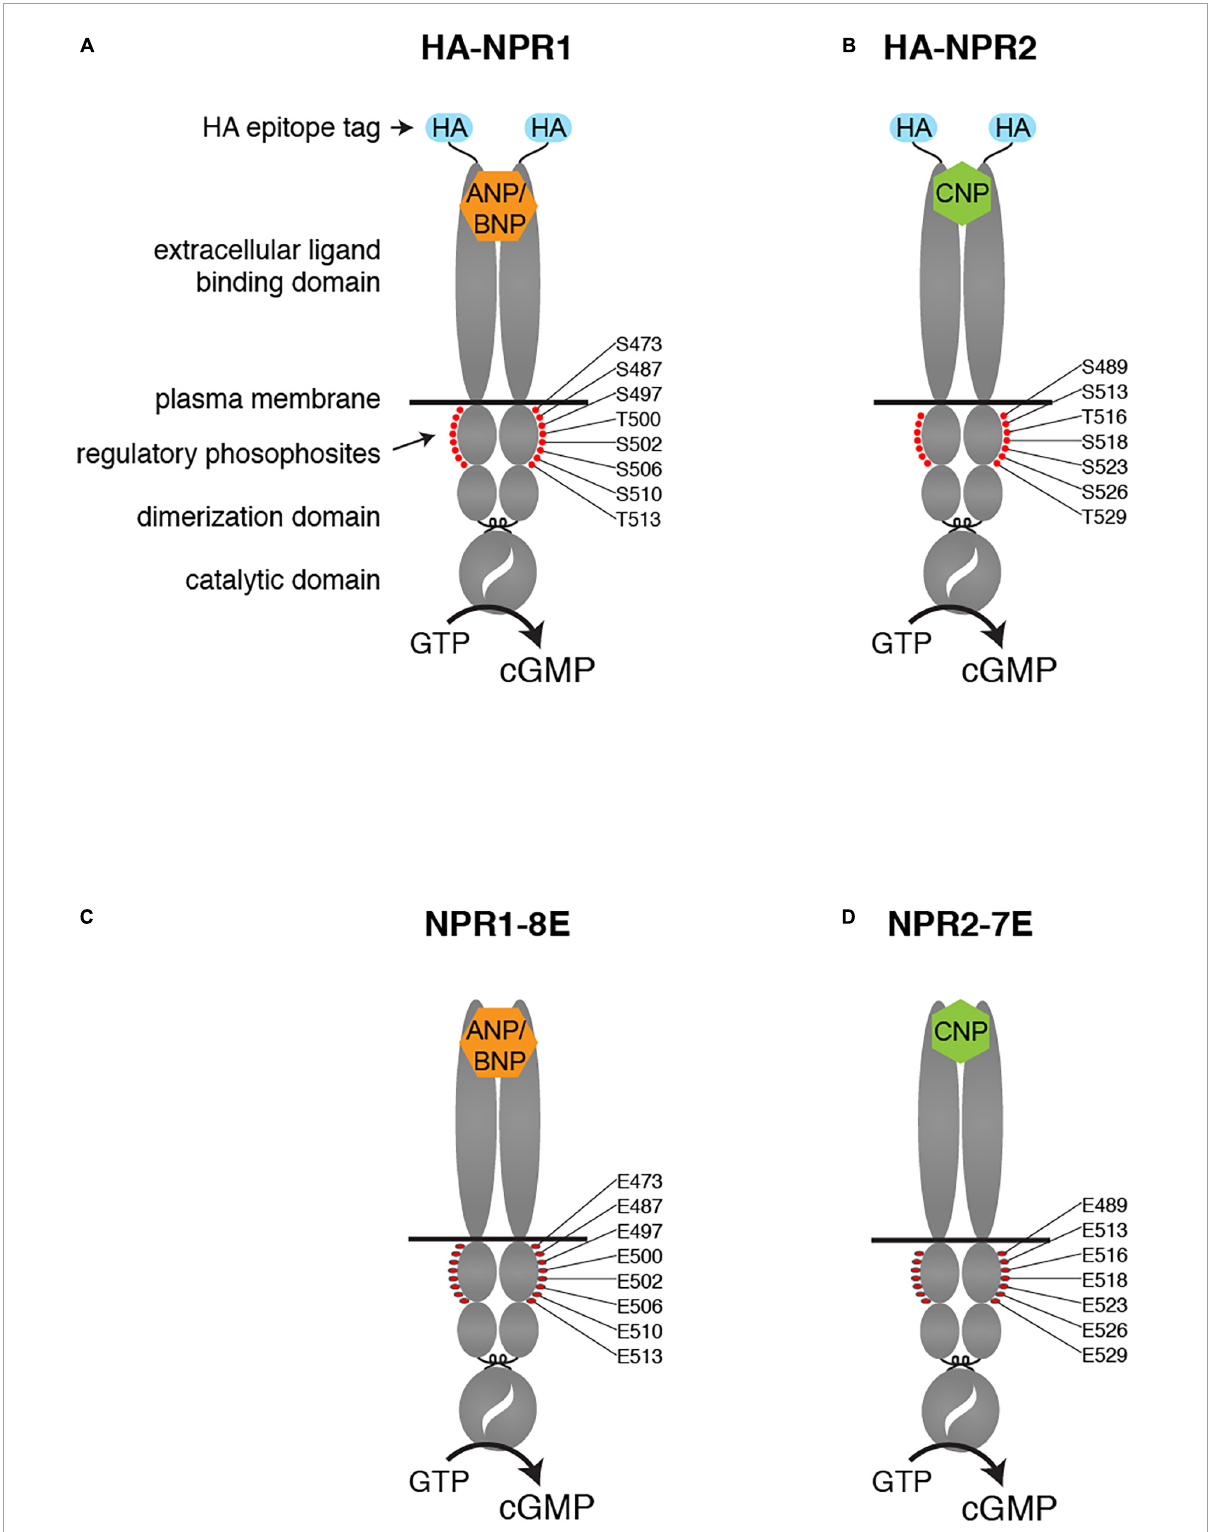
FIGURE1 Modifications of the NPR1 and NPR2 proteins in HA-NPR1, HA-NPR2, NPR1-8E, and NPR2-7E mice. Diagrams show the domains of each protein, including the HA epitope tag at the N-terminus (A,B) and the glutamate substitutions for regulatory phosphosites within the kinase homology domain (C,D)